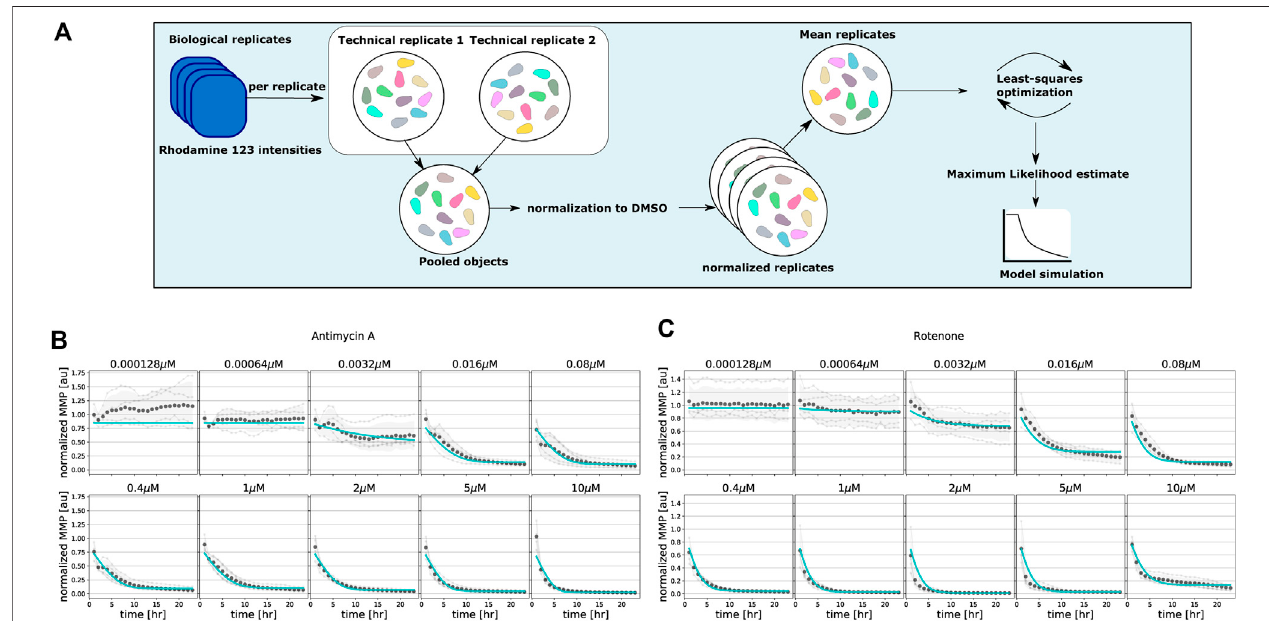
FIGURE3| Model fi ttingtoclassicalmitochondrialinhibitorsantimycinAandrotenone. (A) Flowchartillustratingthestepsforsingle-cellanalysis,normalizationand model parameter estimation. (B, C) Quanti fi ed MMP dynamics and model fi ts upon exposure of HepG2 cells to antimycin A (B) and rotenone (C) at 10 concentrations. Gray lines and symbols represent individual experimental replicates, black dots and shading represent the mean and standard deviation of all replicates, and cyan lines represent best fi ts with the basic model. Note that all model parameters are kept free during parameter estimation.